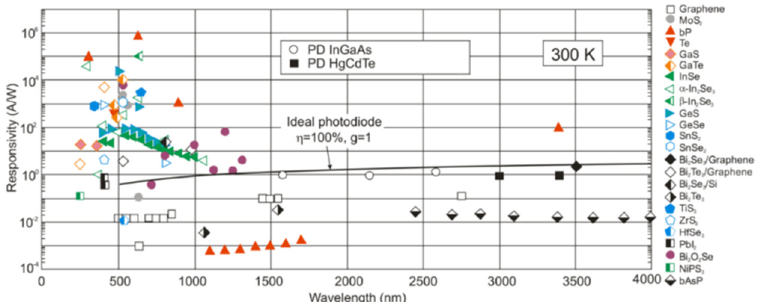
Figure 5. Spectral sensitivity of photodetectors made of 2D layered materials at 300 K. The black line shows the spectral sensitivity of an ideal photodiode with 100% QE and g = 1. The sensitivity of commercially available photodetectors (InGaAs and HgCdTe photodiodes) is presented for comparison [21].